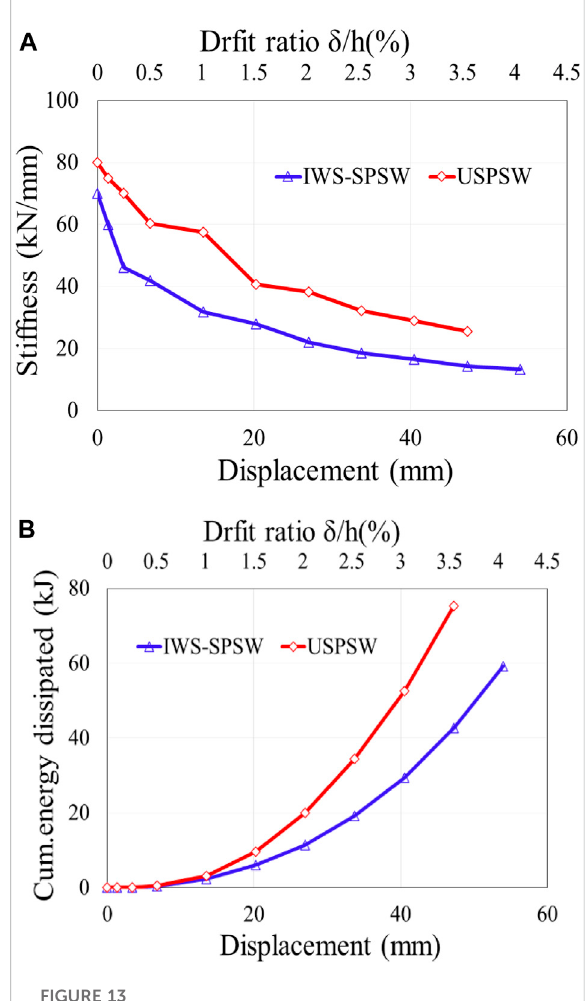
FIGURE 13 (A) Stiffness degradation, (B) cumulative energy